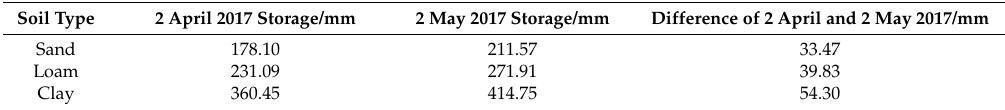
Table 3. Irrigation on soil water supply with different soil textures.